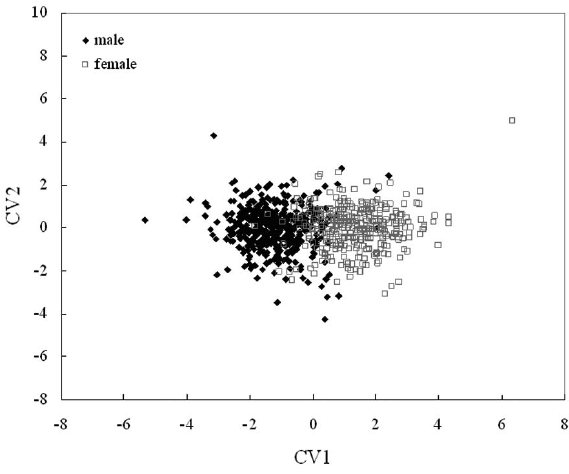
F Ig . 4. – Plot of canonical variables (CV1 vs. CV2) for male and female beak morphological variables of O. bartramii